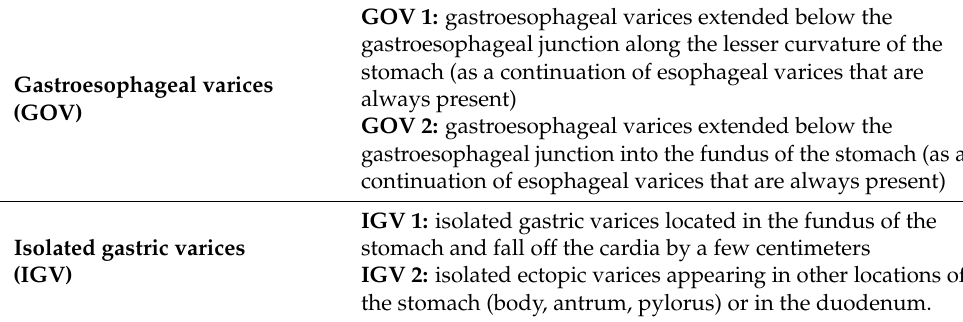
Table 3. Classification of gastric varices according to Sarin Classification